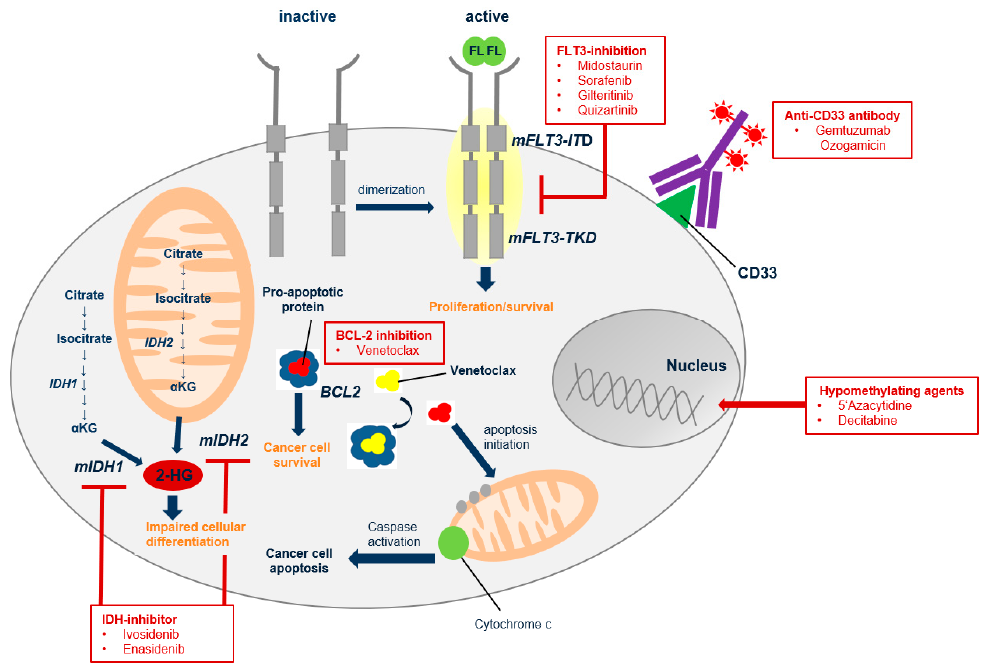
Figure 2. Potential targets for prophylactic and therapeutic interventions after allogeneic stem cell transplantation (allo-SCT) in patients with acute myeloid leukemia (AML). mFLT3-ITD (mutant FMS-like tyrosine kinase 3-internal tandem duplication); mFLT3-TKD (mutant FMS-like tyrosine kinase 3-tyrosine kinase domain); FL (FLT3 ligand); bcl2 (b-cell lymphoma 2); IDH1 (isocitrate dehydrogenase 1); IDH2 (isocitrate dehydrogenase 2); α KG (alpha ketoglutarate); mIDH1 (mutant isocitrate dehydrogenase 1); mIDH2 (mutant isocitrate dehydrogenase 2); 2HG (2-hydroxyglutarate)